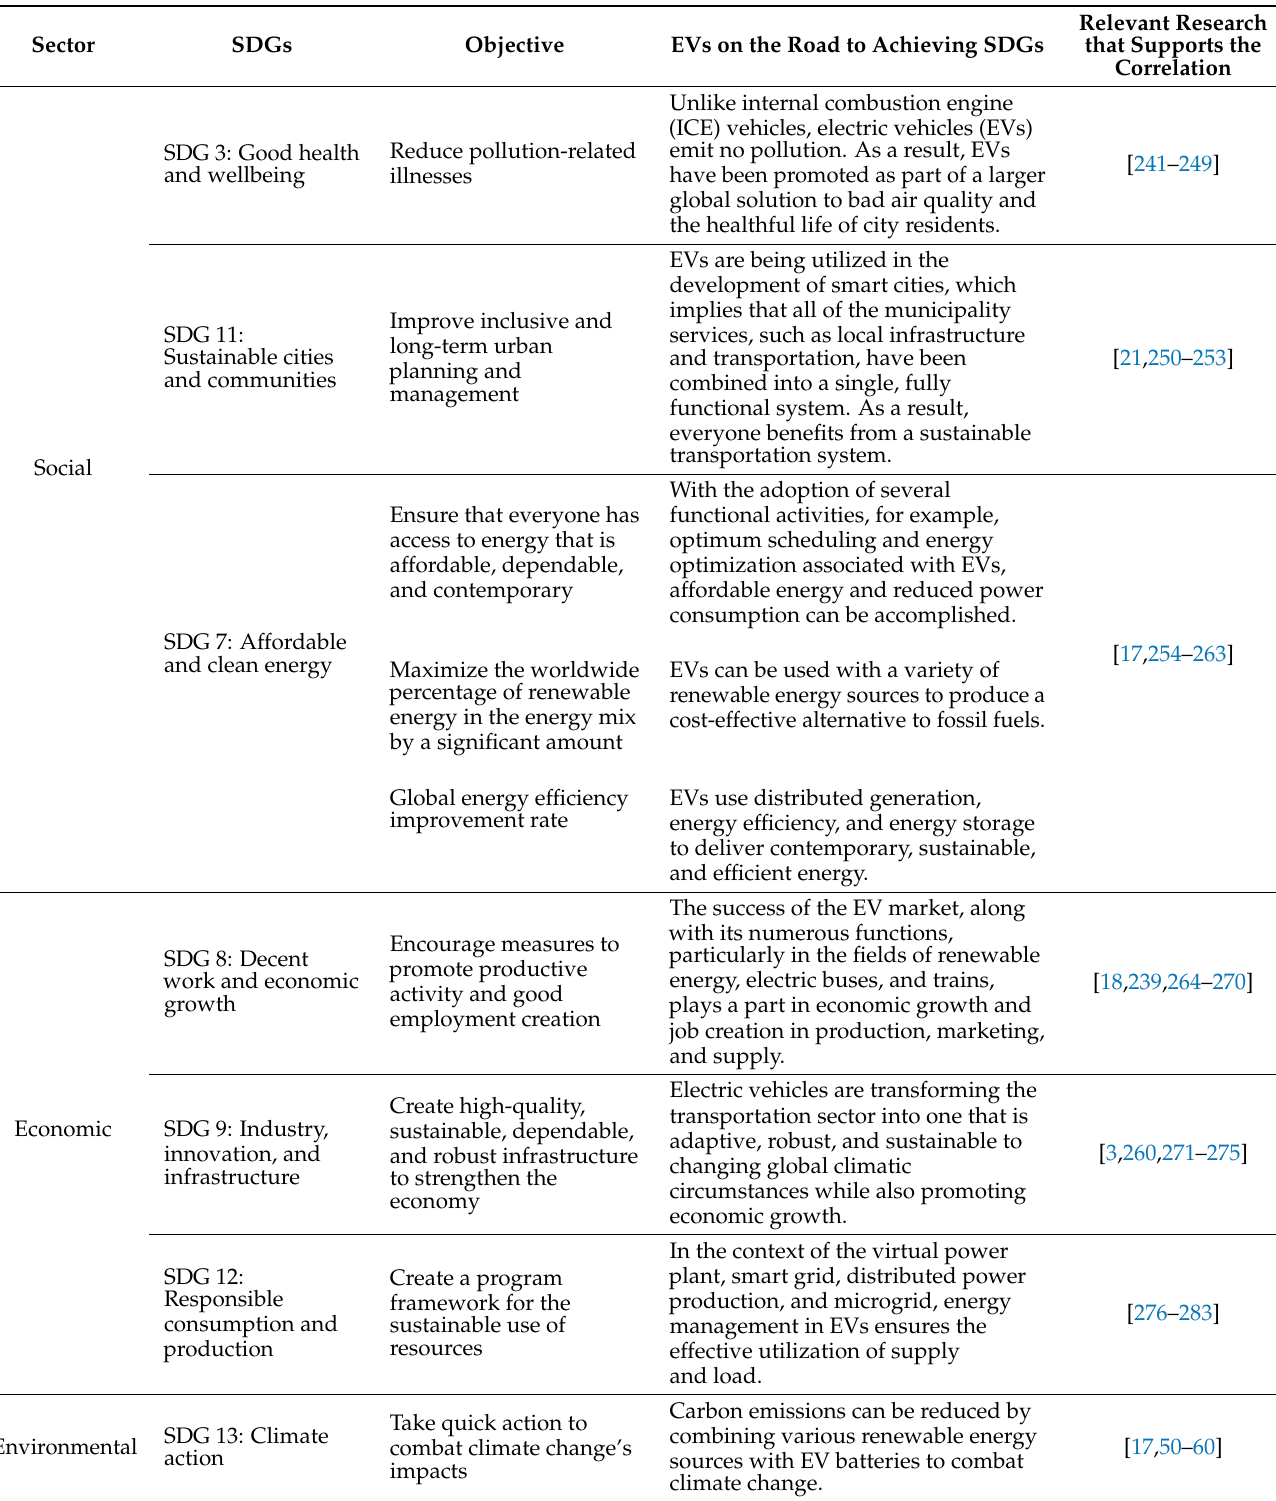
Table 6. The correlation between EVs and